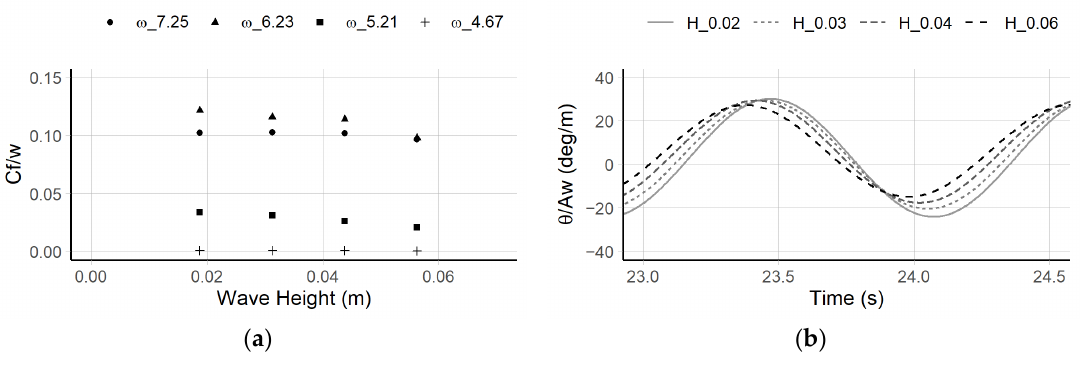
Figure 11. ( a ) Capture factor against the wave heights for different wave frequencies studied; ( b ) motion response per wave amplitude for different a non-dimensional wave frequency of 0.97.